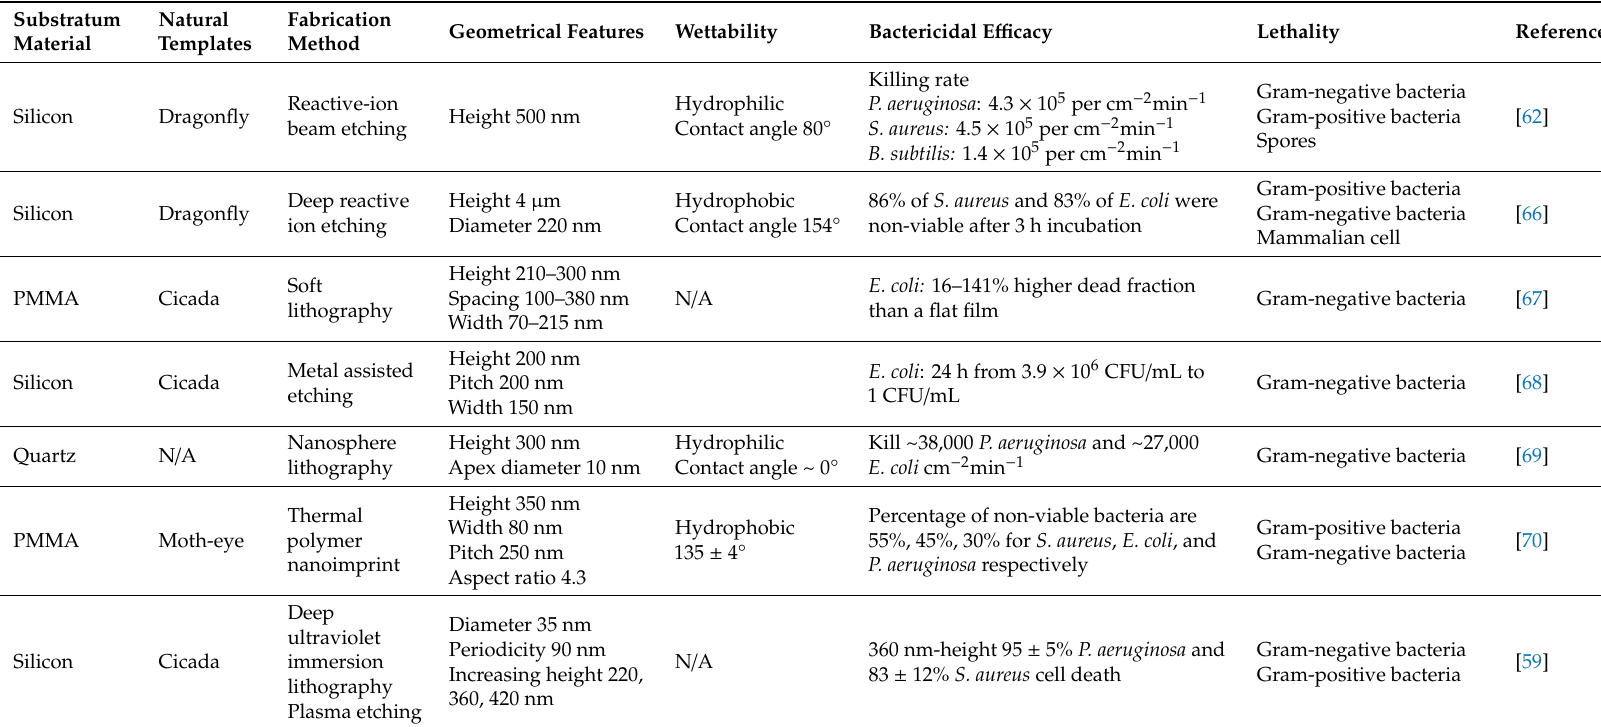
Table 3. Artificial biomimetic